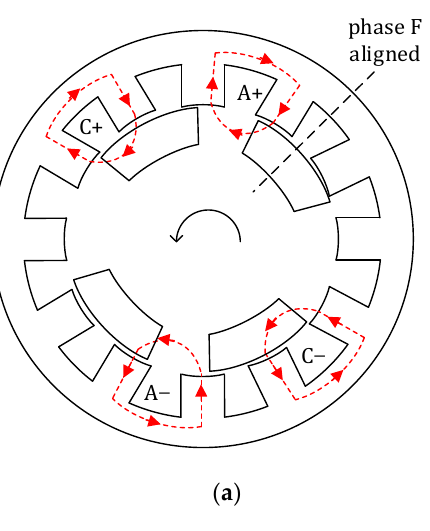
Figure 5. Magnetic fields of the proposed SRM: ( a ) magnetic fields when the previous phase of phase A is aligned; ( b ) magnetic fields when phase A is aligned.